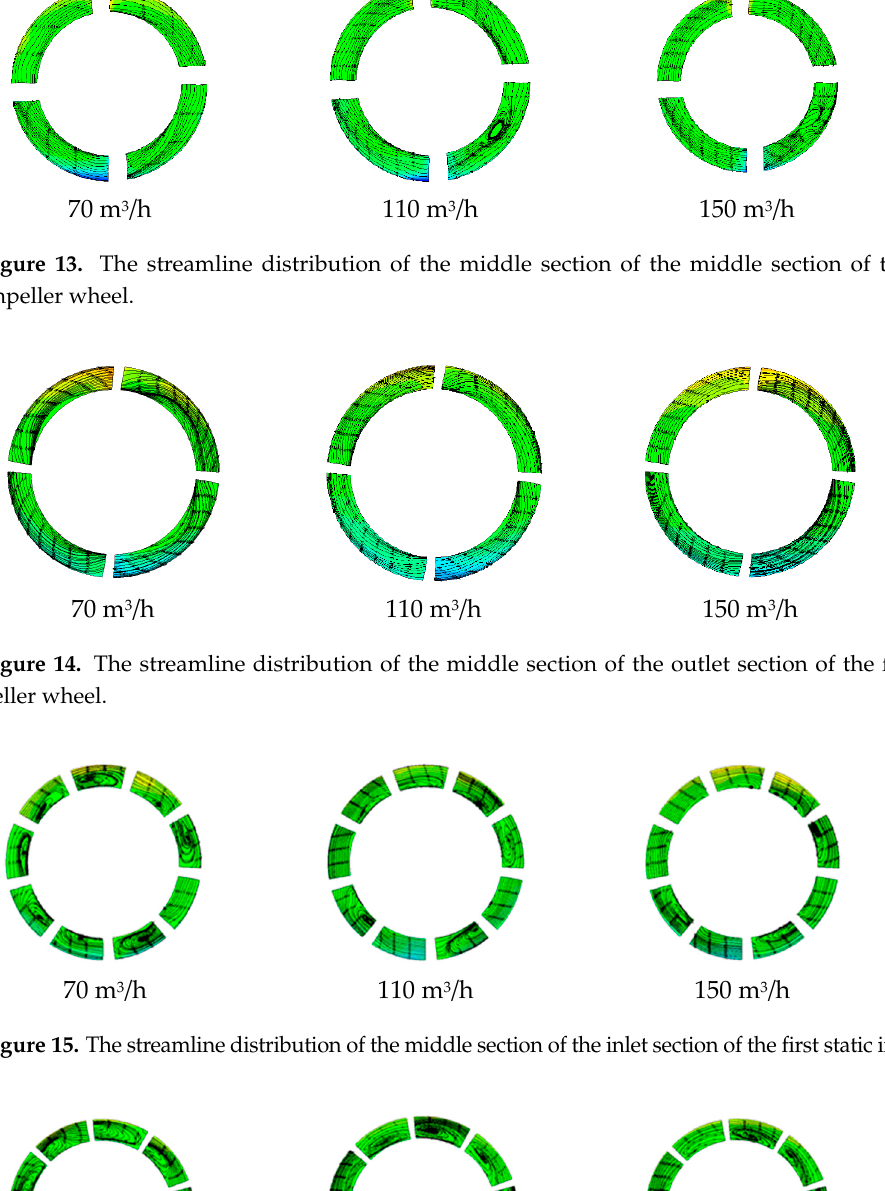
Figure 13. The streamline distribution of the middle section of the middle section of the first im- peller wheel.